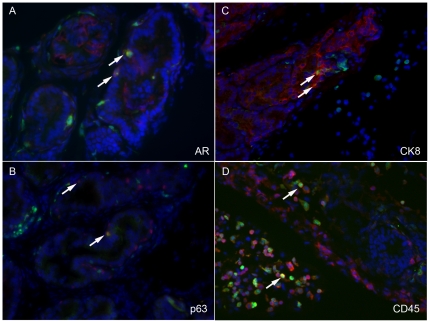
BMDCs incorporated into the prostate during regrowth.Immunofluorescence staining localized GFP-BMDCs (green) with prostate-specific markers (red). DAPI stained the nuclei (blue). A) Androgen receptor, B) p63, and C) cytokeratin 8 were expressed in recruited GFP-BMDCs. D) GFP-BMDCs had minimal co-expression of the hematopoietic marker, CD45.